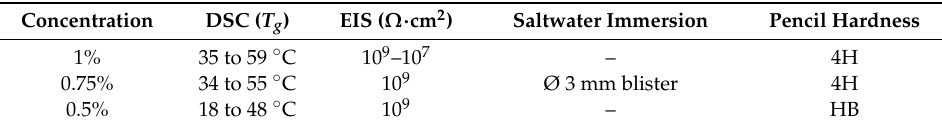
Table 7. Measurement results of different Fosfosal